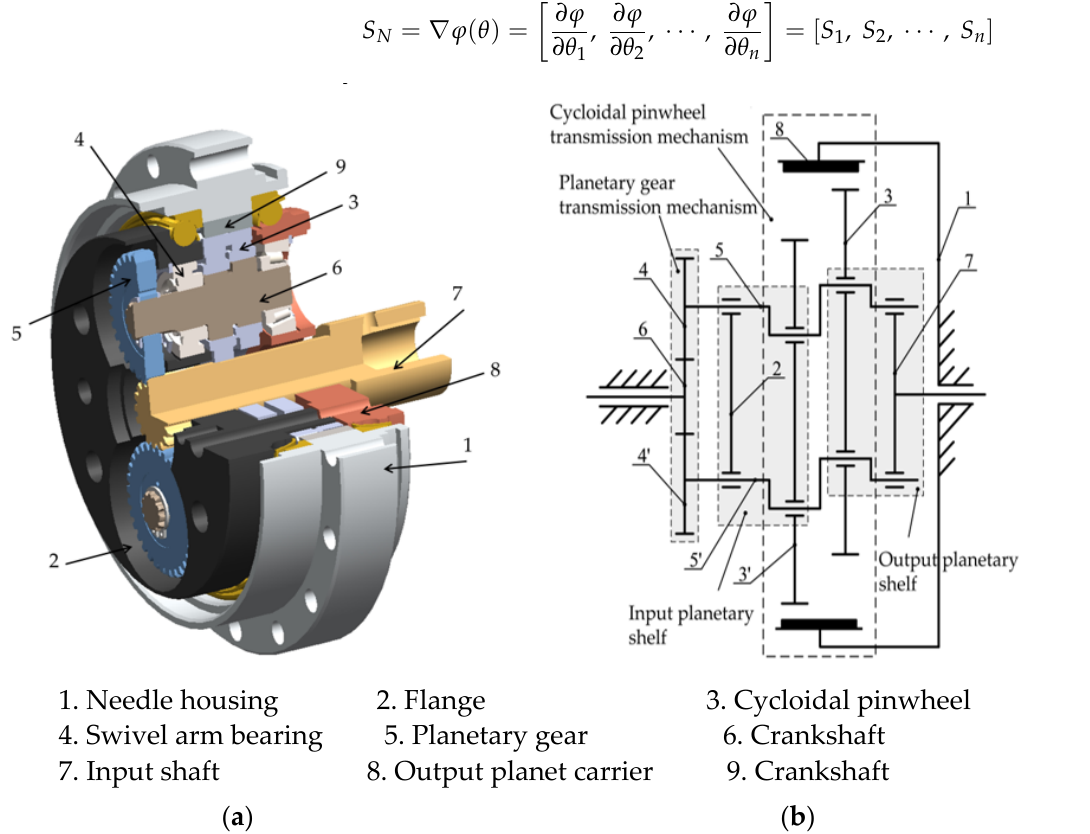
Figure 1. Schematic diagram of RV-40E reducer structure: ( a ) structure diagram; and ( b ) schematic diagram.